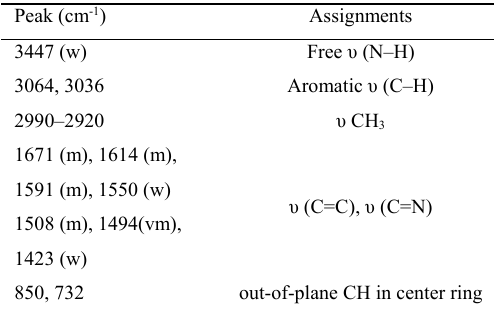
Table 1. FT-IR absorption peaks of neocuproine